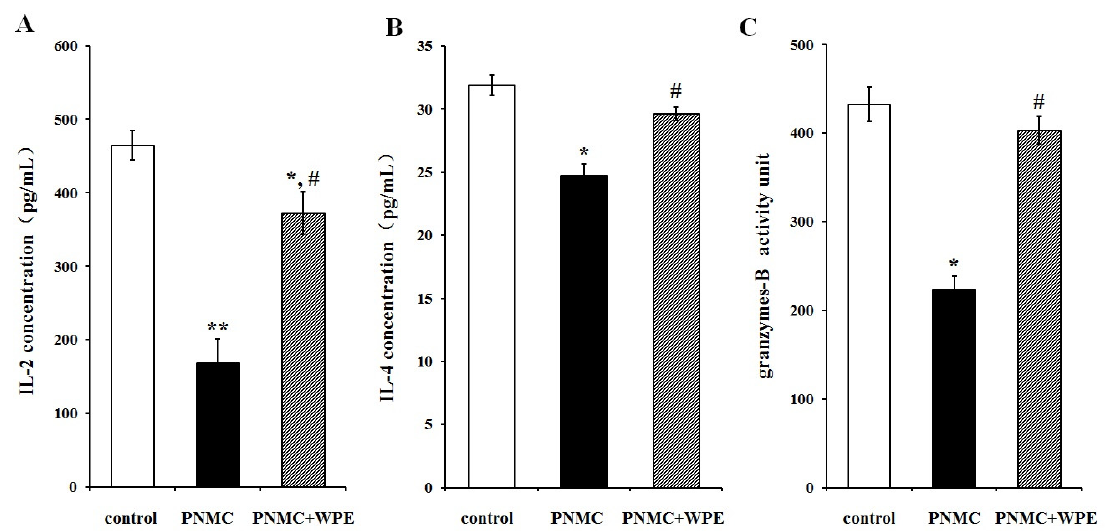
Figure 5. Effects of WPE on select cytokine/granzyme production in splenocytes exposed to PNMC. Splenocytes were cultured for 48 h in the presence of PNMC (10 − 4 M) or WPE (1.0 μ g/mL) together with PNMC. Levels of ( A ) IL-2; ( B ) IL-4; and ( C ) granzyme B released into culture media were then measured by ELISA. Results shown are means ± SD of three separate experiments. * p < 0.05 or ** p < 0.01 vs. untreated control; # p < 0.05 vs. PNMC treatment.